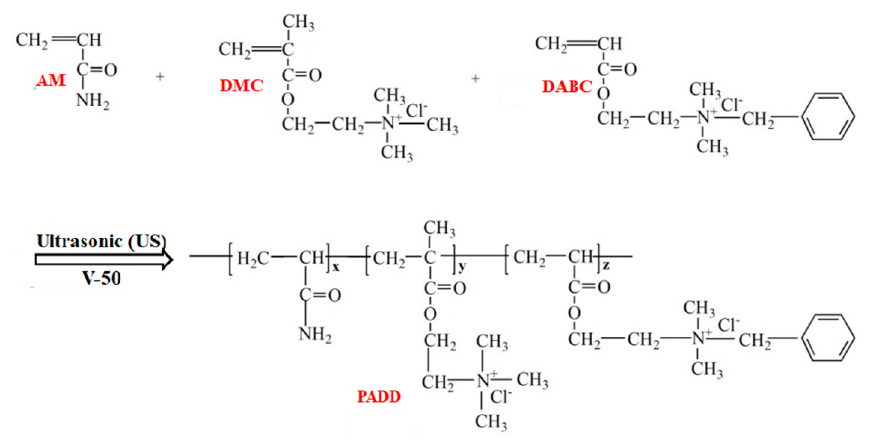
Figure 1. The scheme of polyacrylamide P (AM-DMC-DABC) copolymerization.